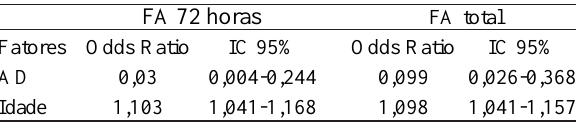
FA = fibrilação atrial; AD = estimulação atrial direita; IC = intervalo de confiança de 95%; NS = não significante.